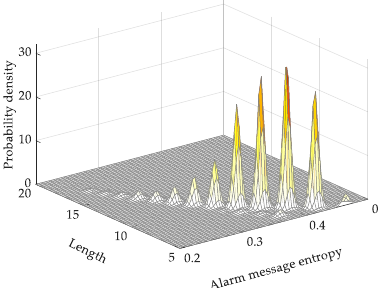
Figure 5. Probability density map of average absolute alarm-message entropy.